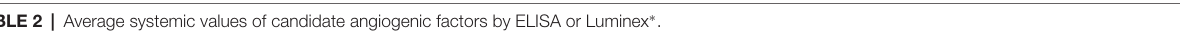
TABLE 2 | Average systemic values of candidate angiogenic factors by ELISA or Luminex ∗ . Angiogenic factor